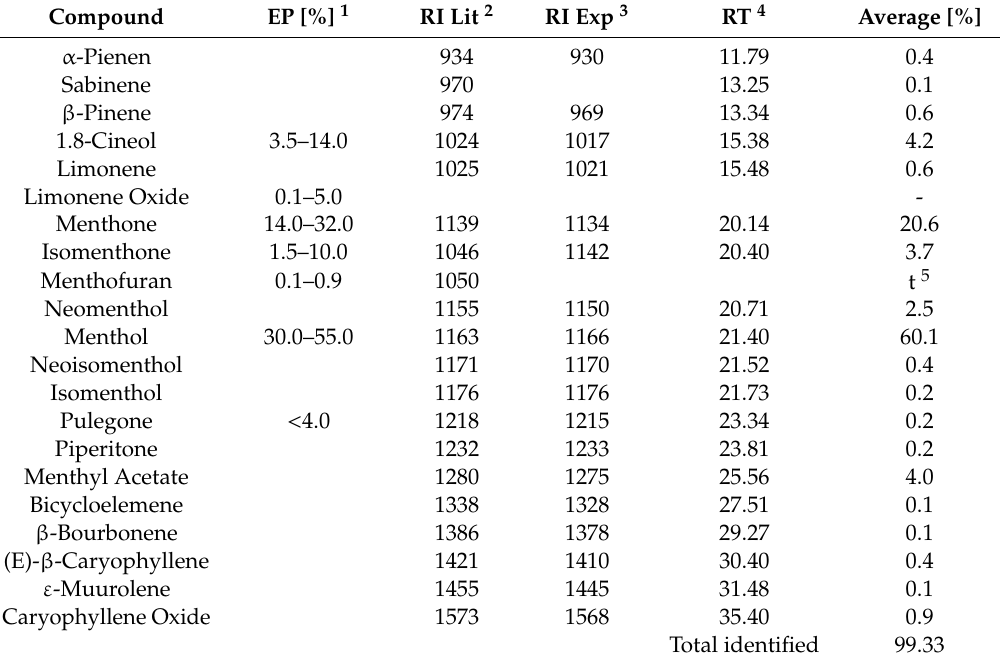
Table 2. Chemical composition of peppermint oil encapsulated in the maltodextrin